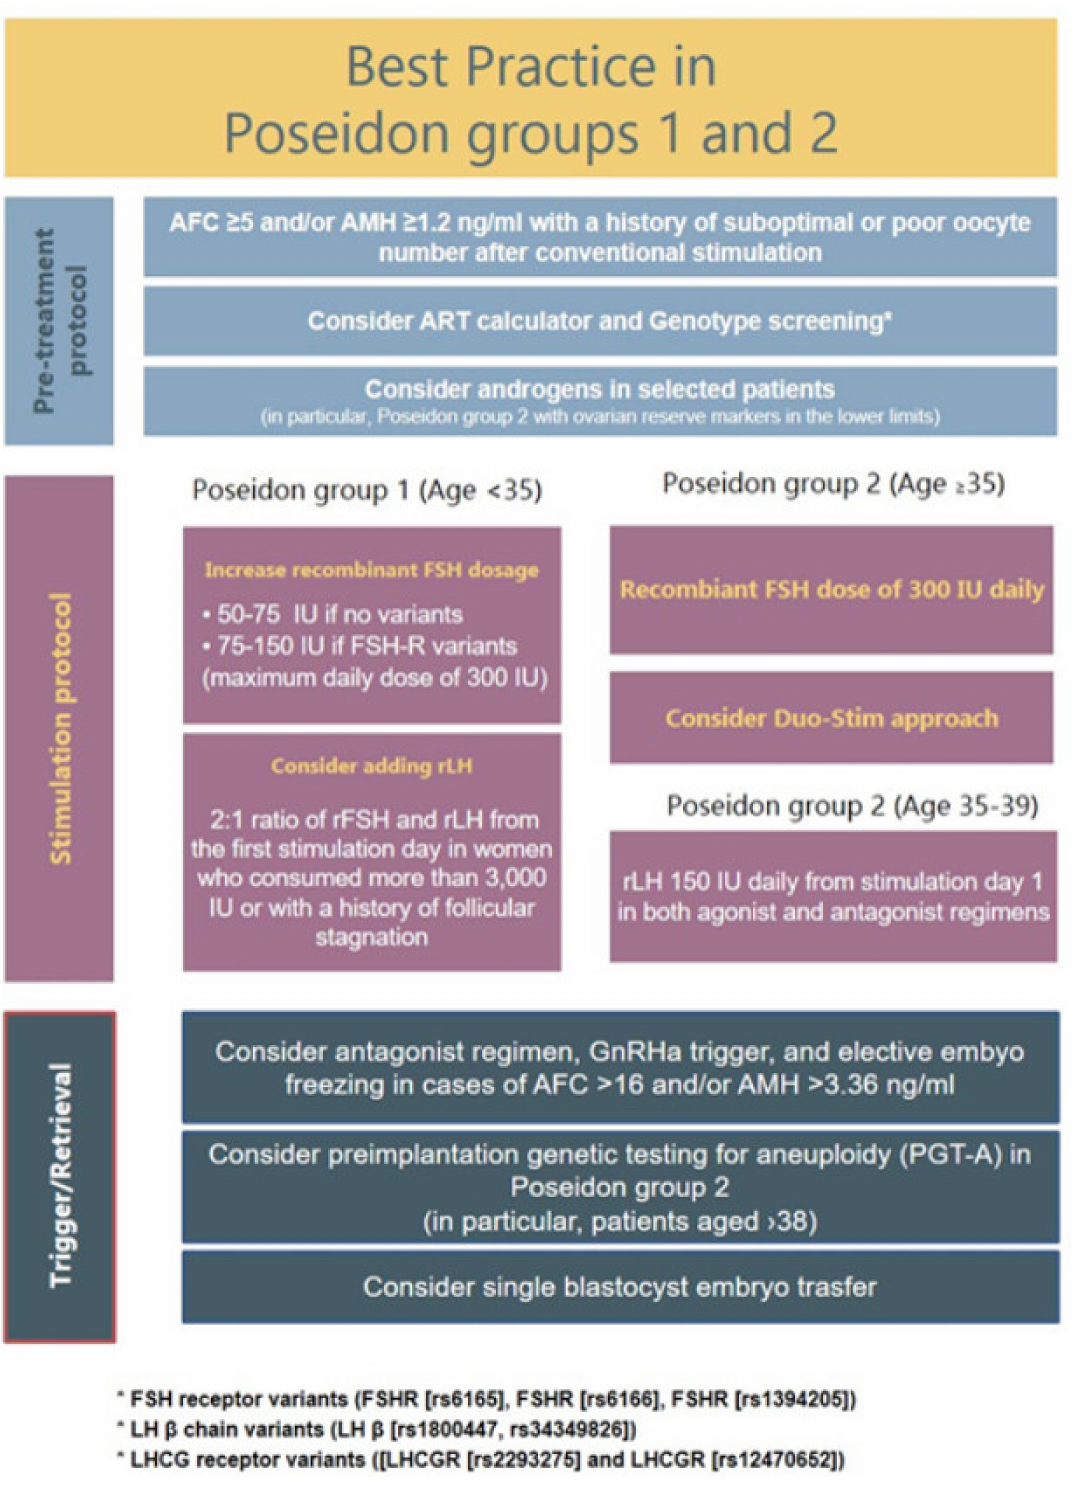
Figure 4. Best practice in POSEIDON groups 1 and 2. POSEIDON recommends the use of gonadotropin releasing hormone (GnRH) antagonist co-treatment for all patients in POSEIDON groups 1 or 2. Ovarian stimulation strategy: First choice should be an increase in the daily rFSH dose by 75–150 IU. In POSEIDON group 1, patients with follicular stagnation at follicle sizes 1–12 mm, rLH 75–150 IU daily should be added from day 1 of stimulation. In POSEIDON group 2, rLH 75–150 IU daily should be added to all patients from day 1 of stimulation. Ovulation trigger strategy: GnRH agonist (GnRHa)